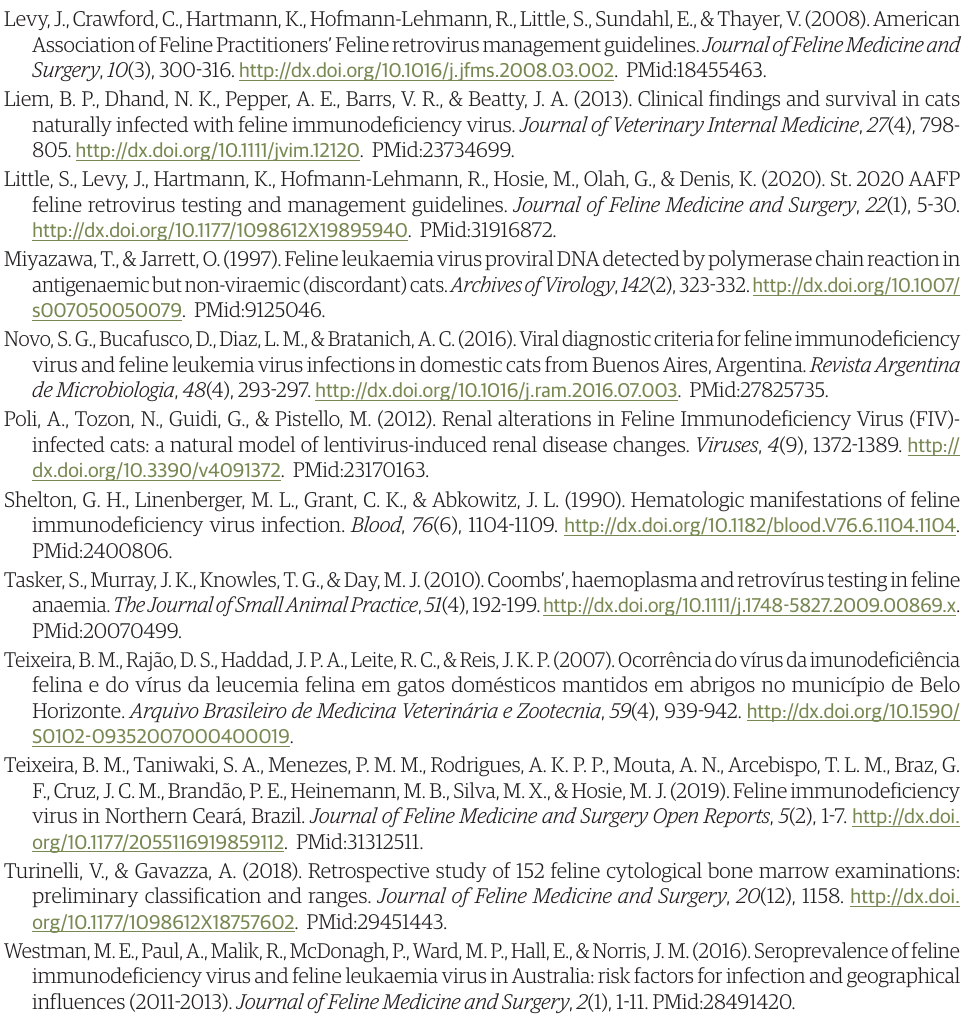
Lacerda et al. 2020. Brazilian Journal of Veterinary Medicine, 42, e110020. DOI: 10.29374/2527-2179.bjvm110020